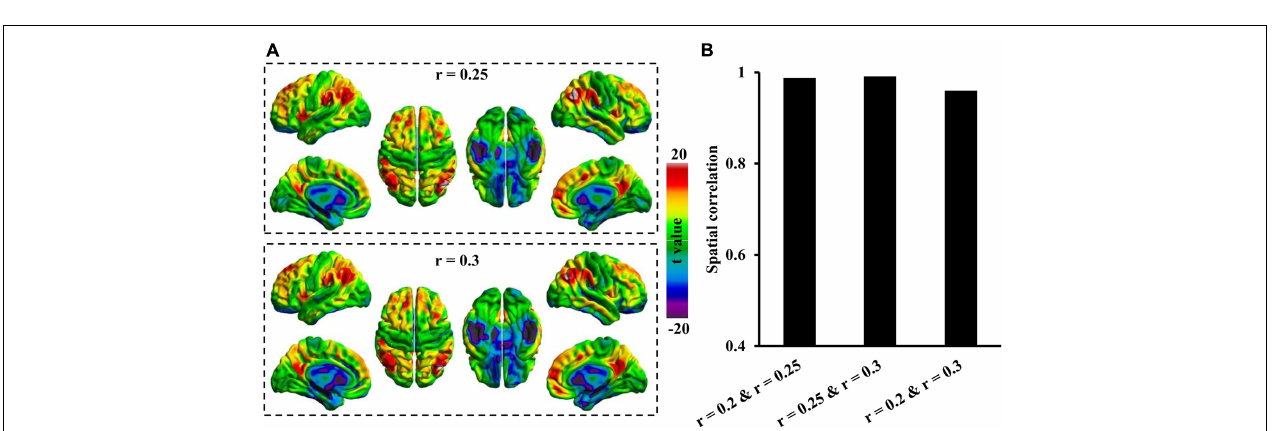
FIGURE 3 | Spatial similarities of Asso distribution across different thresholds. (A) The whole brain Asso distribution patterns were calculated under thresholds of r = 0.25 and r = 0.3. (B) The spatial correlations defined using Pearson correlation coefficient across different thresholds were calculated. The Asso distribution across different threshold values showed high spatial